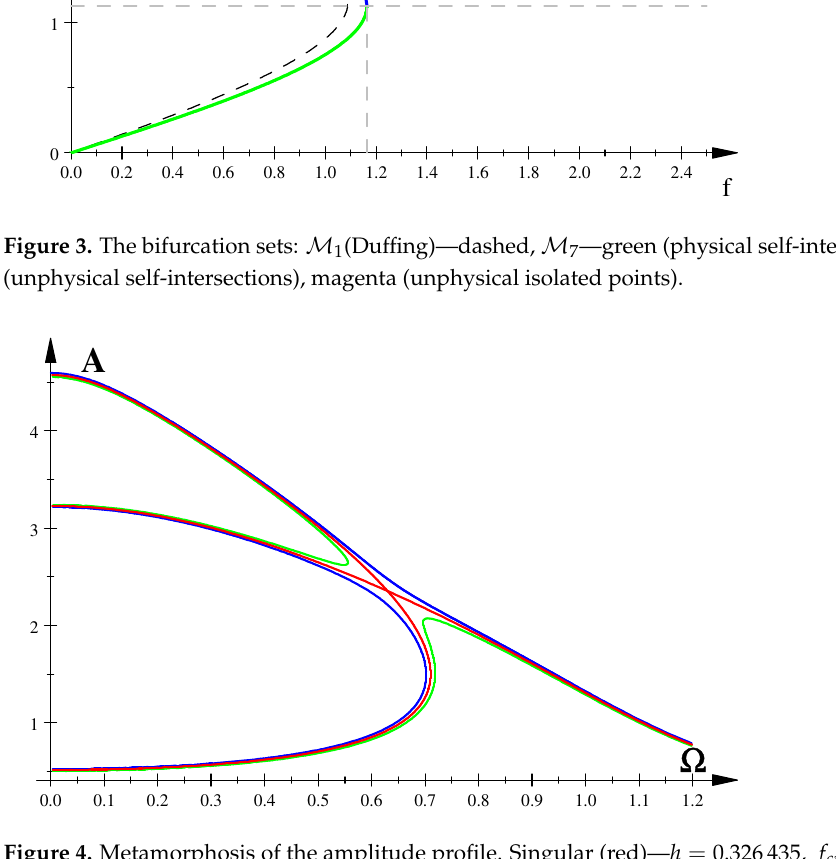
Figure 4. Metamorphosis of the amplitude profile. Singular (red)— h = 0.326435, f cr = 0.5, green— h = 0.326435, f = 0.49 < f cr , blue— h = 0.326435, f = 0.51 > f cr